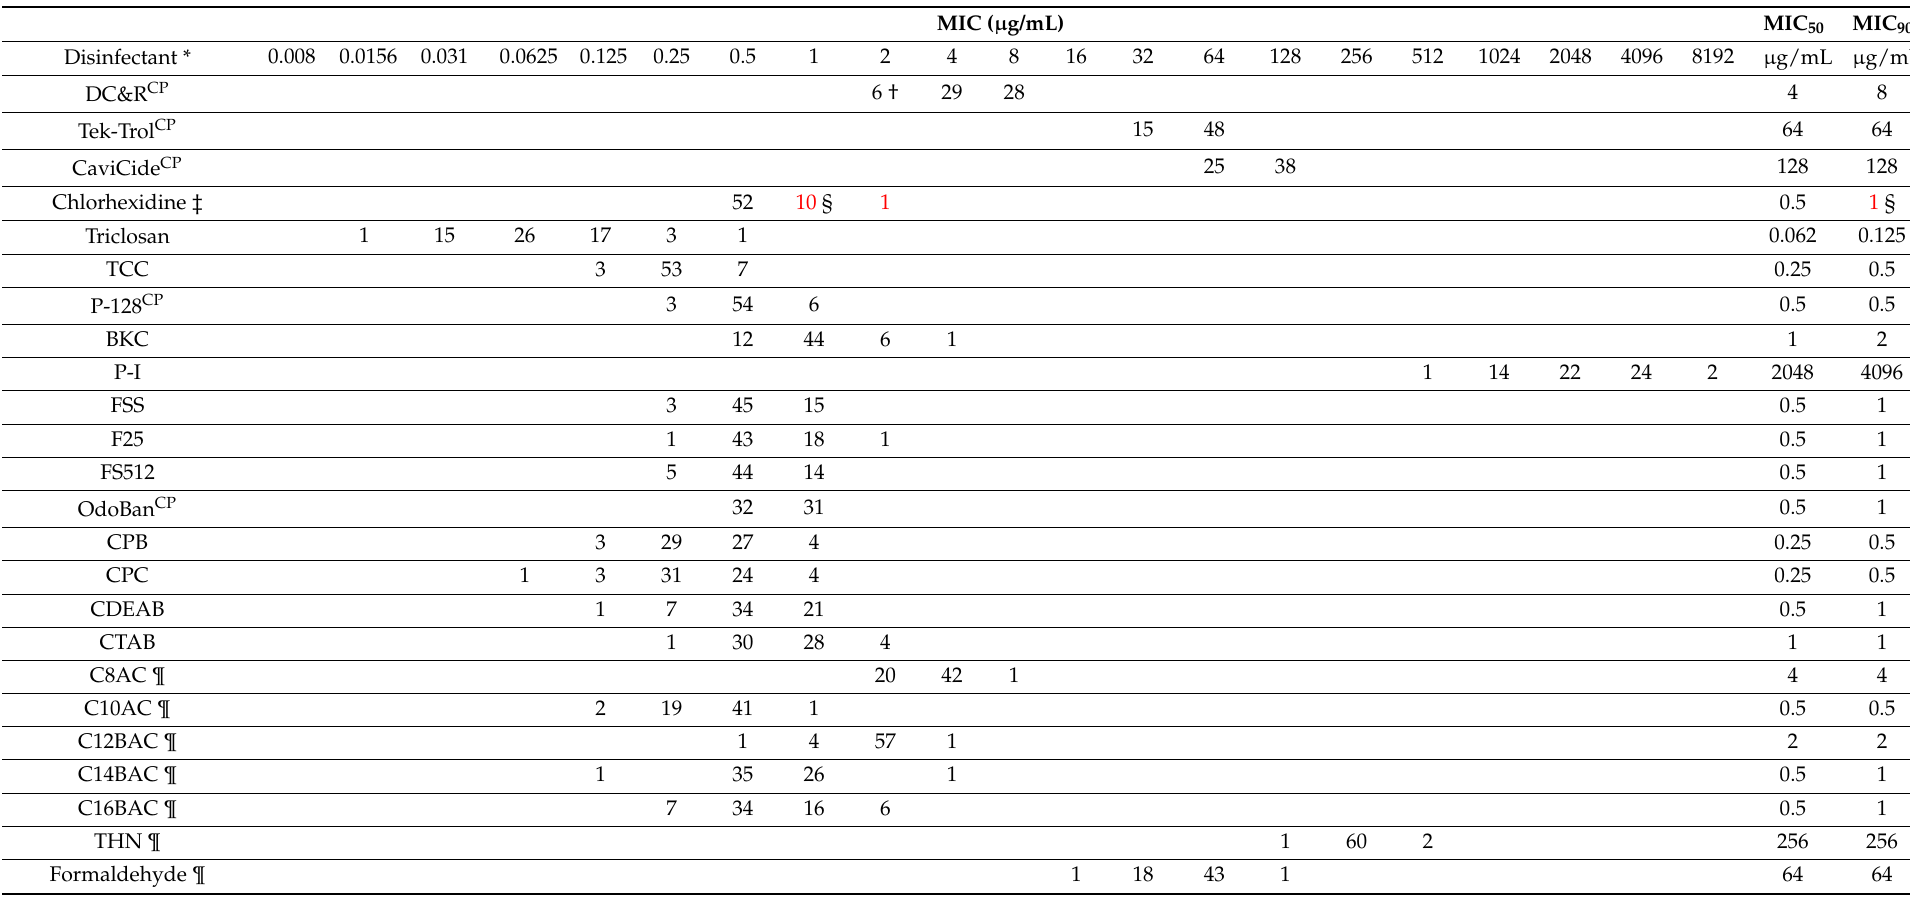
Table 4. Distribution of disinfectant susceptibility profiles for 63 Staphylococcus aureus strains isolated from swine feces. MIC = minimum inhibition